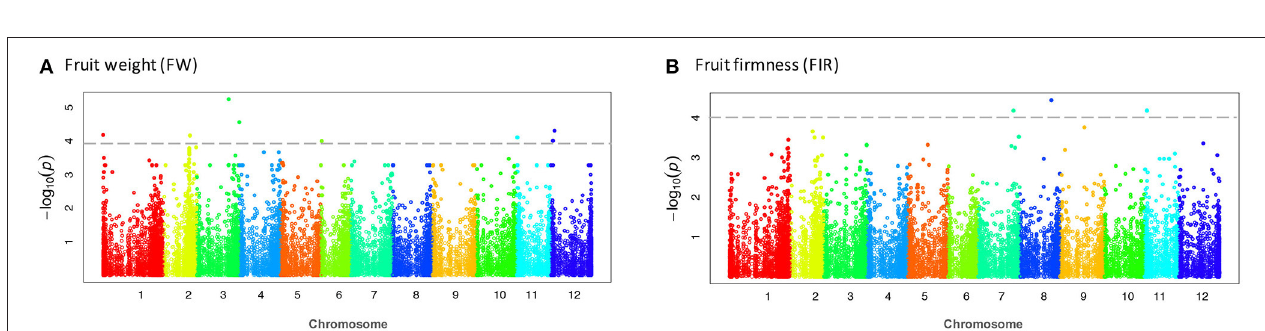
FIGURE 3 | Quantile-quantile (Q-Q) plot for fruit weight and fruit firmness . Q-Q plots showing the ratio of the observed p -values (blue dots) compared to the expected p -value distribution (red line) for (A) fruit weight and (B) fruit firmness.